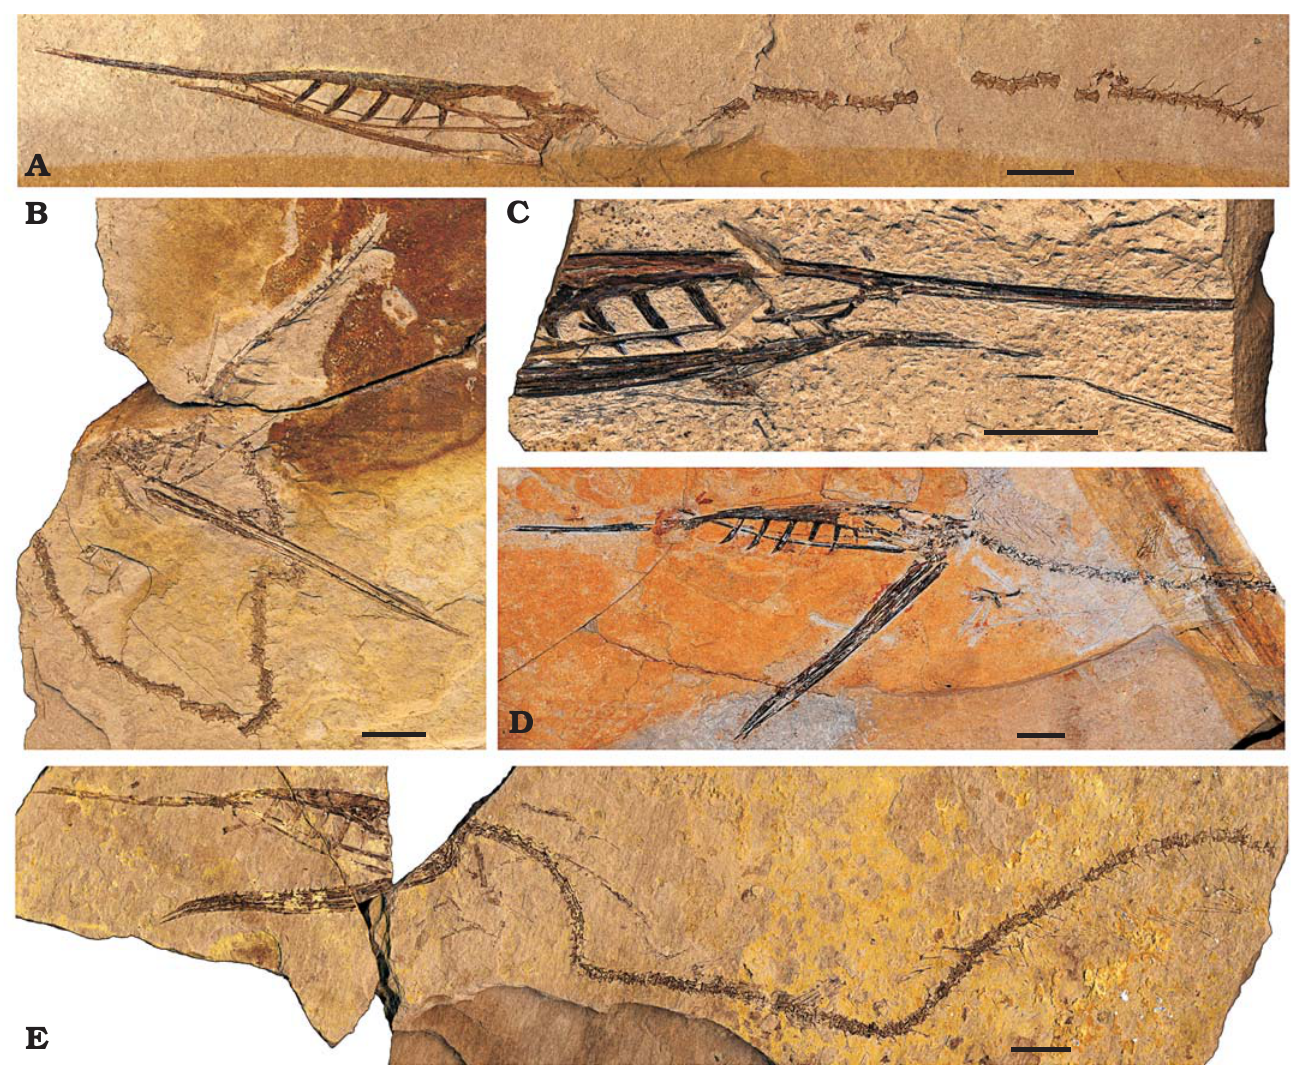
Fig. 2. Alepisauroid fish Polymerichthys sp. from Sakhalin Island, Holmsk Formation, late Oligocene (A, B) and Kurasi Formation, Middle–Late Miocene (C–E). A . ZIN 311p. B . ZIN 310p. C . ZIN 313p. D . ZIN 312p. E . ZIN 314p. Scale bars 10